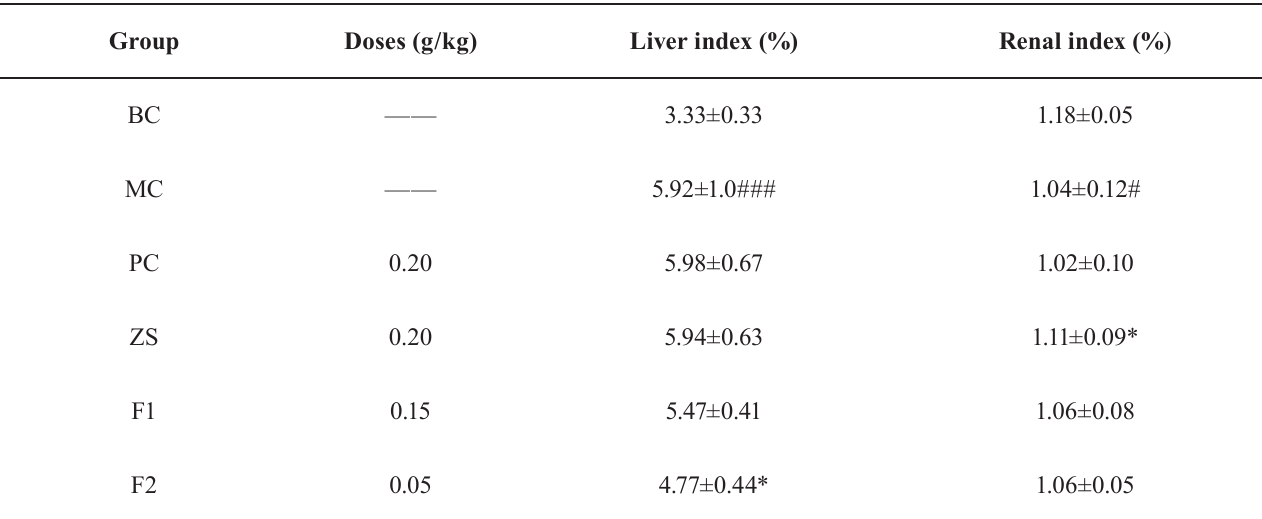
TABLE II - Effects of BCLE on Liver and Renal Index of KK-A y Mice ( x ±s, n=12)